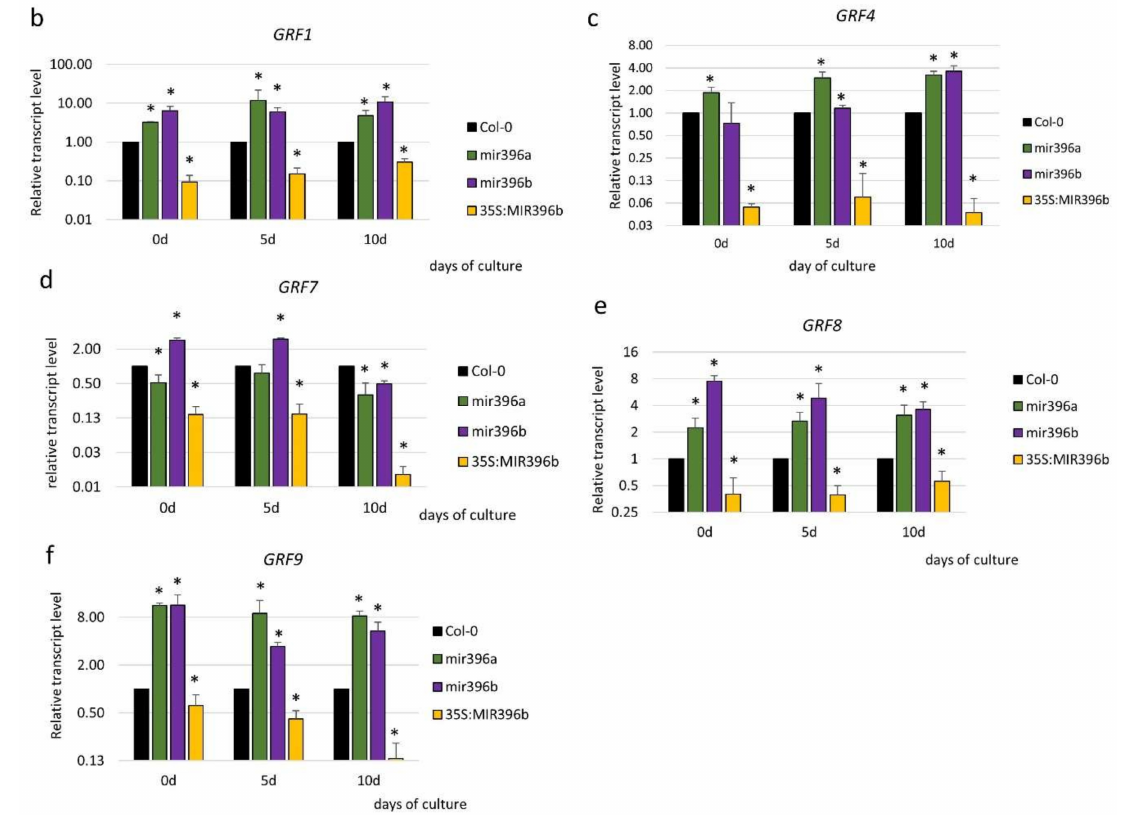
Figure 4. The regulatory relationship between miR396 and the GRF genes during SE. The expression of ( a ) the GRF genes in the SE culture of Col-0 and ( b ) GRF1 , ( c ) GRF4 , ( d ) GRF7 , ( e ) GRF8 , and ( f ) GRF9 in the SE cultures of the mir396a , the mir396b mutants, and the 35S: MIR396b line. The explants were induced on a standard SE induction medium (E5). The relative transcript level was normalized to the internal control ( At4g27090 ) and calibrated to a WT culture of the same age. Values that were significantly di ff erent from those of a WT culture of the same age are indicated with asterisks (*) ( p < 0.05; n = 3 ±